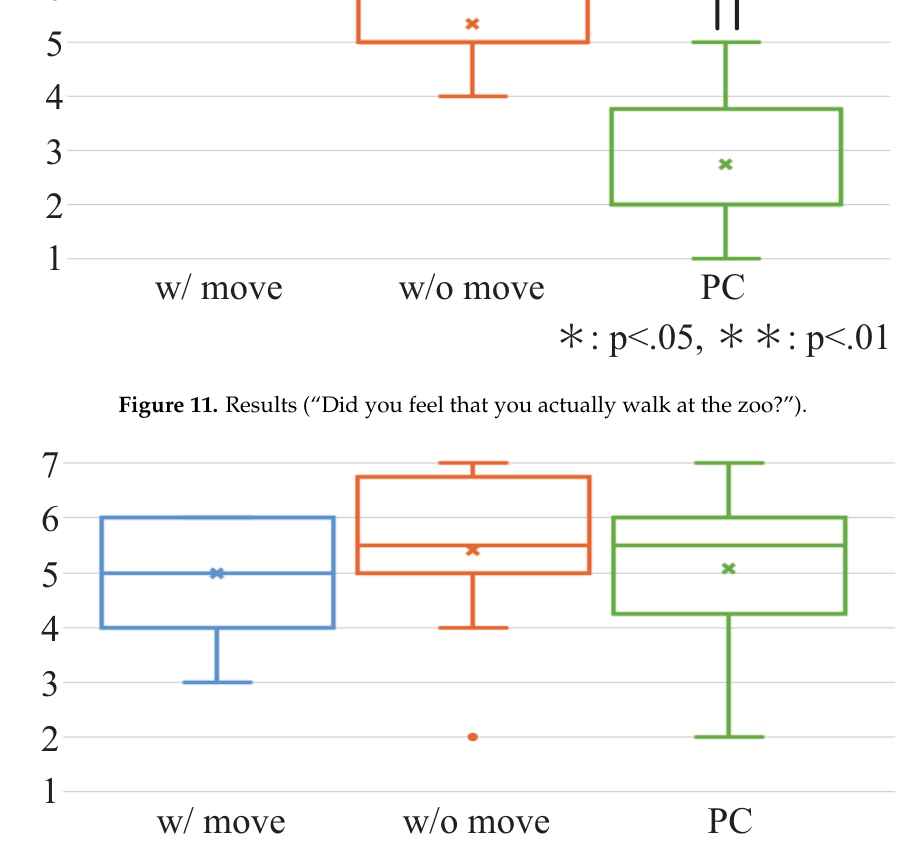
Figure 12. Results (“Did you feel that you have been to the zoo before?”)